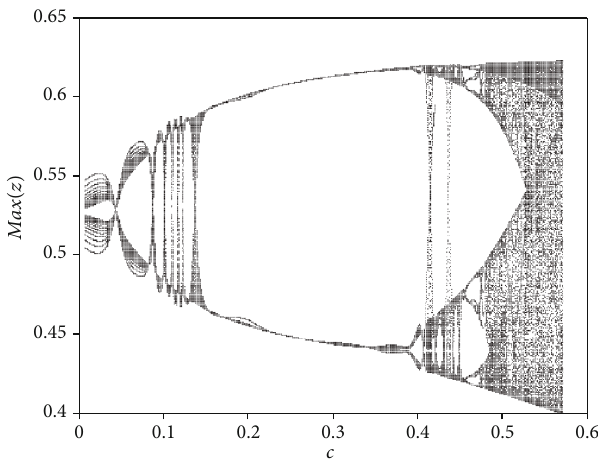
Figure 1: Bifurcation diagram of system (3) using data (87) with varying c , the trajectory of z versus c in the range ð 0, 0 : 6 Þ